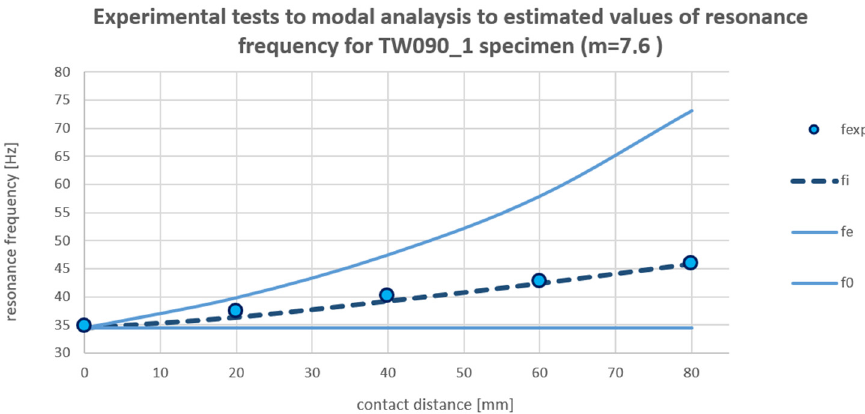
Figure 12. Comparison of experimental tests with modal analysis and estimated values of resonance frequency for the TW090_1 specimen (m = 7.6).